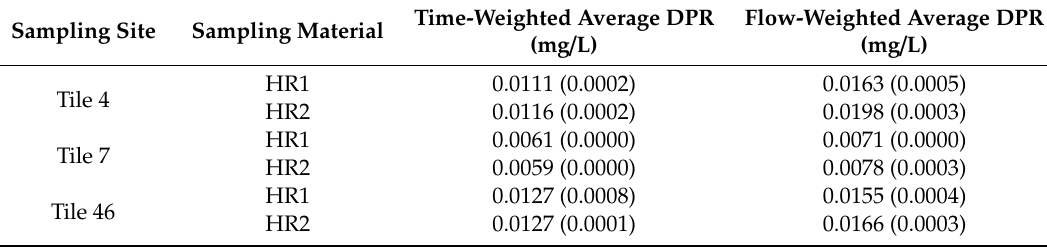
Table 7. Average DRP concentrations in tile water throughout the six-week monitoring period. The DRP concentrations were calculated from the field-calibrated passive sampling method, and averaged with the time and flow volume of each sampling period, respectively. Standard deviations are shown in